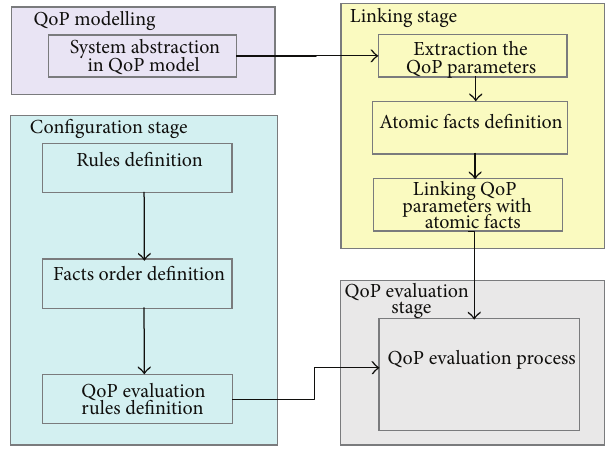
Figure 1: The methodology of QoP evaluation of security mecha-